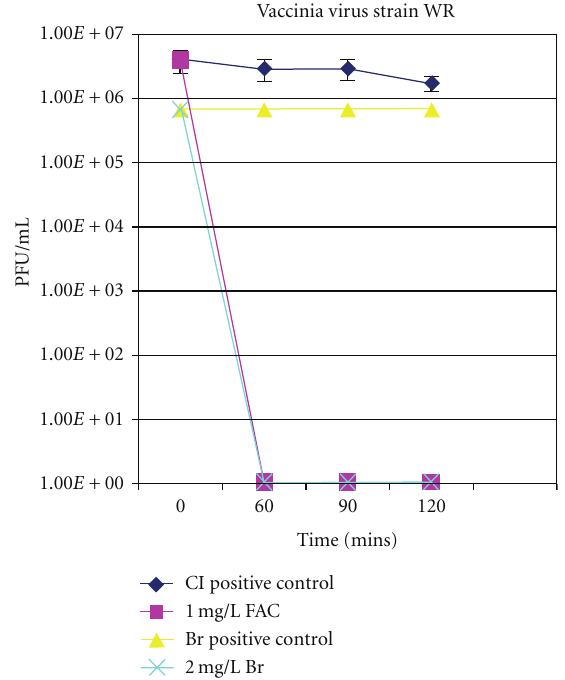
Figure 1: Survival of vaccinia virus strain WR in formulated tap water with 1mg/L FAC and 2mg/L total bromine. Positive control samples consisted of formulated tap water without disinfectant. All samples were incubated at 21 ◦ C, and, at intervals, viral titers were determined as described in Materials and Methods.